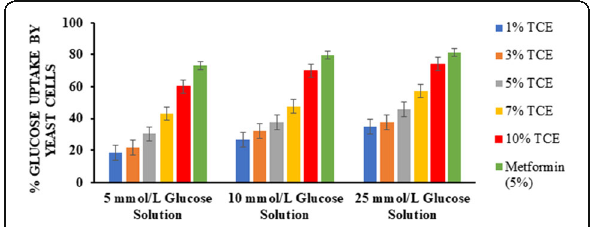
Fig. 3 Percent Glucose uptake by yeast cells of the different concentrations of T. cacao husk extract and the